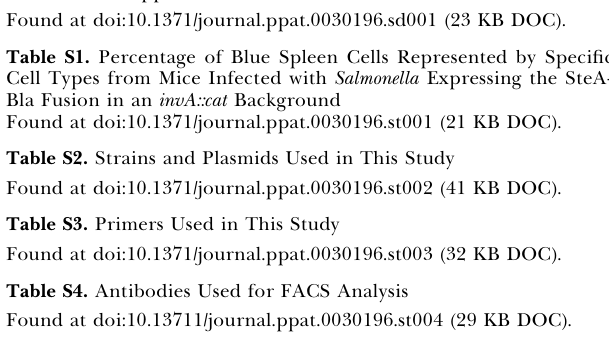
Table S4. Antibodies Used for FACS